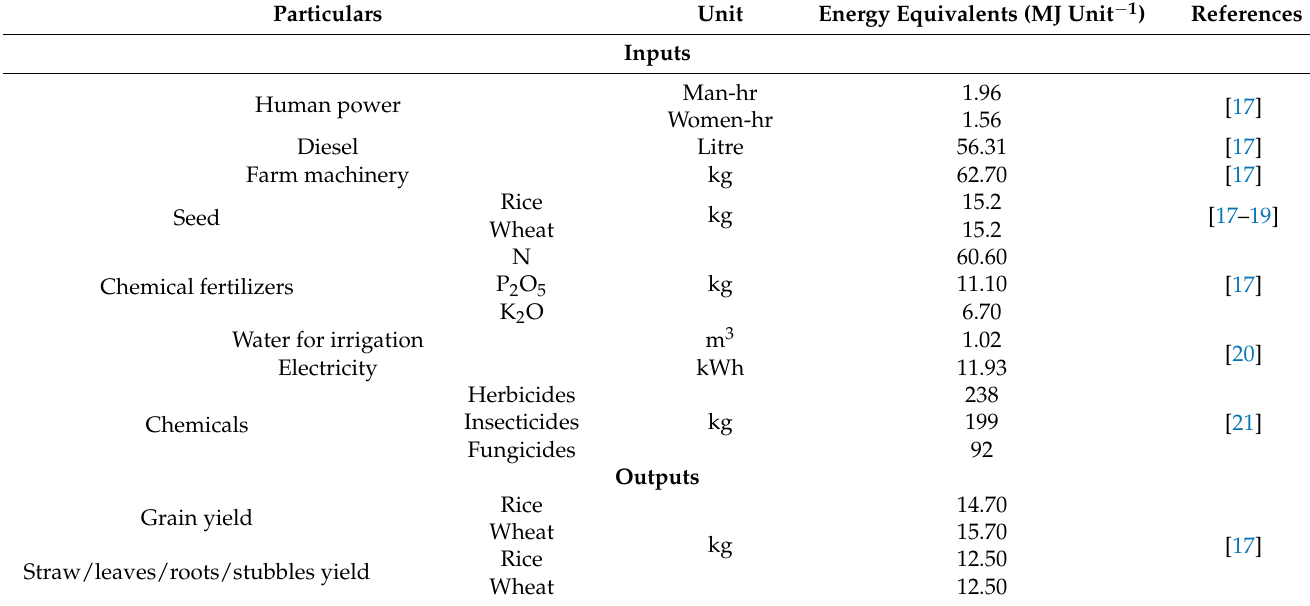
Table 2. Energy equivalents coefficients of inputs and outputs in crop production.